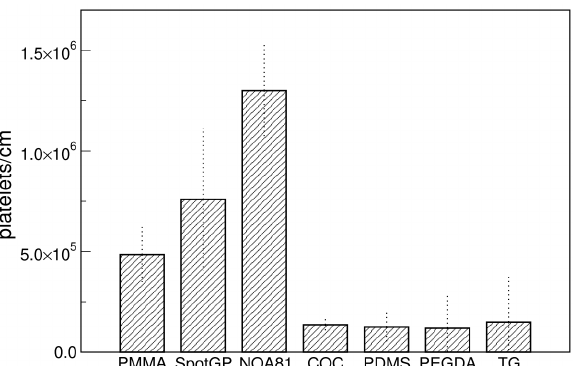
Figure 1. Platelets density on different materials measured with SEM. Data are means of at least four images and standard deviations are shown.